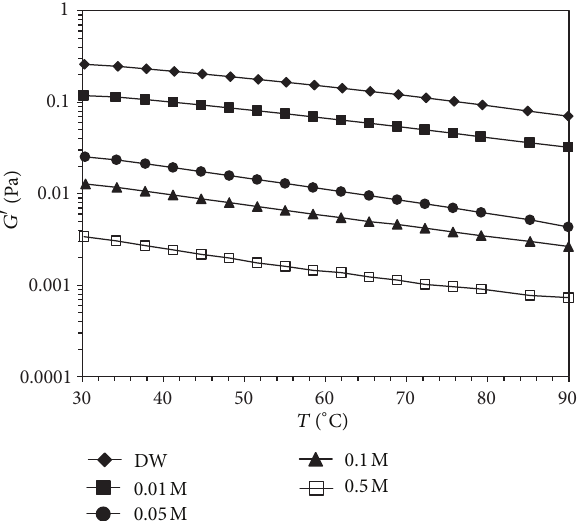
Figure 17: Effect of sodium chloride concentration on storage modulus of copolymer at different